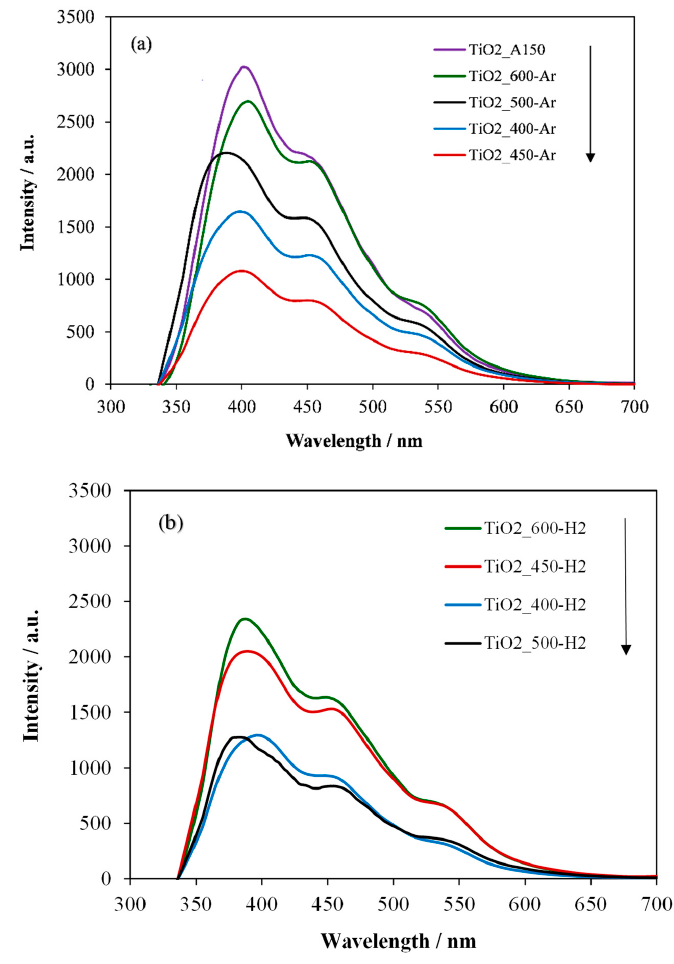
Figure 7. Photoluminescence spectra measured after excitation of titania at λ = 390 nm, ( a ) TiO 2 after hydrothermal treatment at 150 °C and these heat treated in Ar and ( b ) TiO 2 heat treated in H 2 . The morphology of the prepared TiO 2 samples was analysed by SEM technique. In Figure 8, some of the SEM images of TiO 2 samples were illustrated.